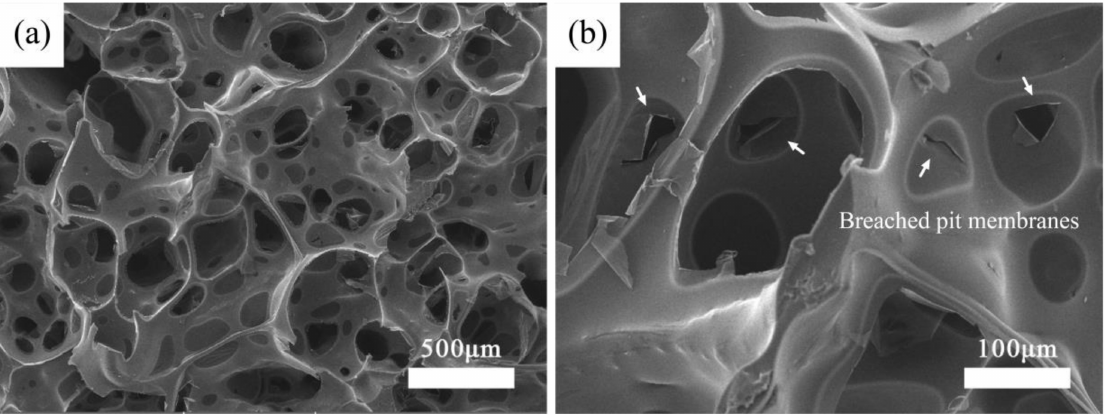
Figure 4. SEM images of BioSiC fabricated with NaOH Method with 40 wt. % PCS ( a ) 100 × and ( b ) 400 ×